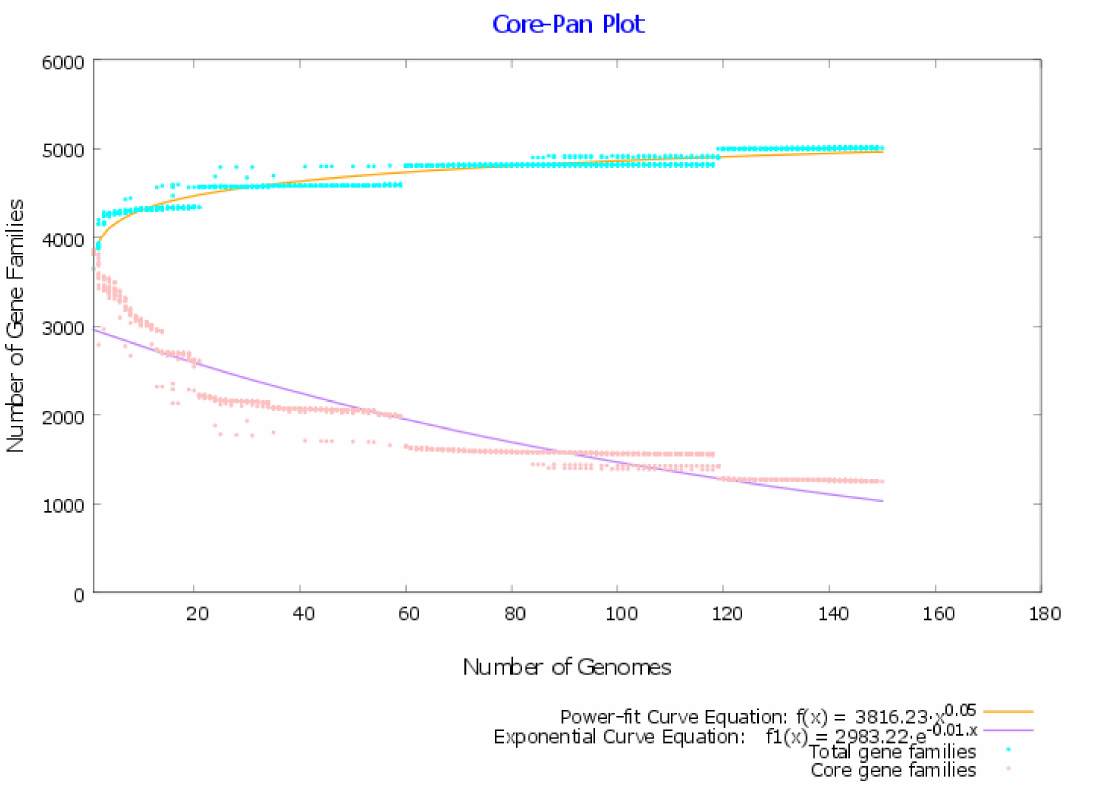
Figure 1. Pan-core plot of 150 Mycobacterium tuberculosis genomes. X-axis shows the number of genomes while the y-axis represents the number of gene families. With the addition of every genome, the pangenome size increased while the core genome size declined. The pangenome curve (shown in brown) has almost flattened, i.e., reached plateau. This suggests that the global gene repertoire of this species is unlikely to change significantly in the future and the pangenome is almost